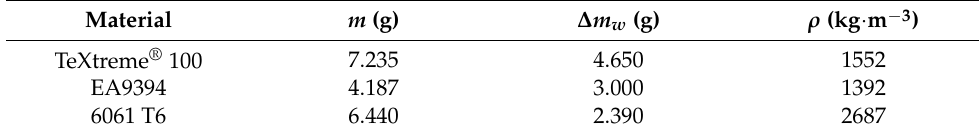
Figure 3. Density measurement configuration. Table 1. Used materials’ densities. Table 1. Used materials’